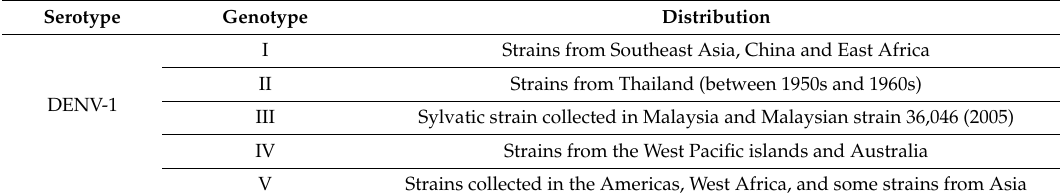
Table 3. Classification of DENV genotypes and their